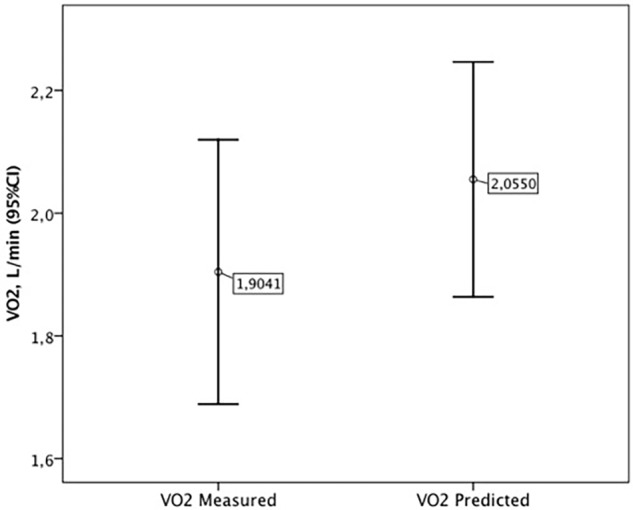
Comparison between VO2peak measured and VO2peak predicted, p = 0.67.